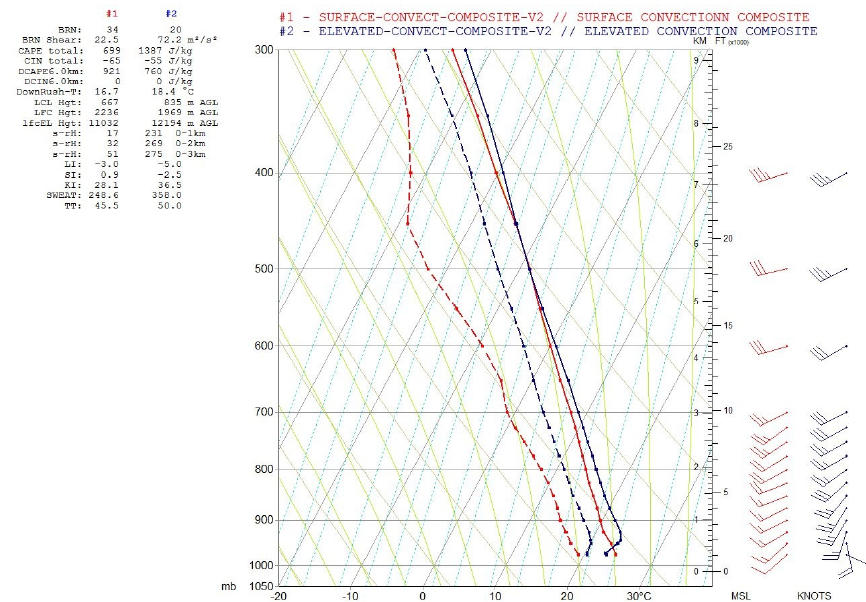
Figure 10. Composite sounding profiles for surface-based convection (red) and elevated convection (blue) on a standard skew-T log p diagram. Temperature traces (°C; solid) and dew point traces (°C; dashed) are accompanied by standard wind plots (right) with speeds in represented in knots. Table 8. Classification of thunderstorm complexes for all cases. TS indicates trailing stratiform; PS indicates parallel stratiform; LS indicates leading stratiform; and NL indicates the system was non-linear and was not classified.